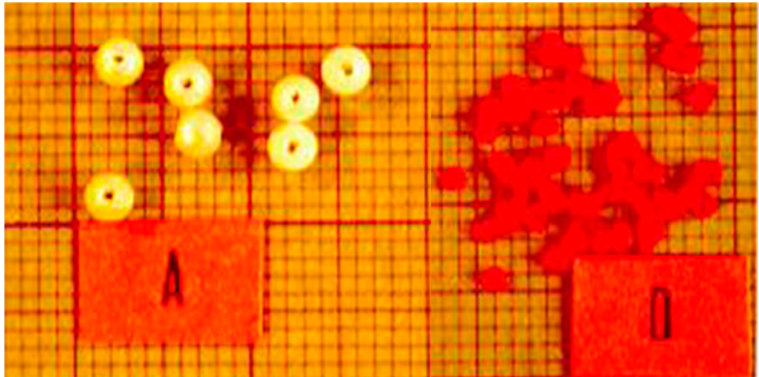
Figure 3. Granulars tested: A: plastic spheres and D: irregular plastic grains (courtesy Schippa and Lamberti [30]).